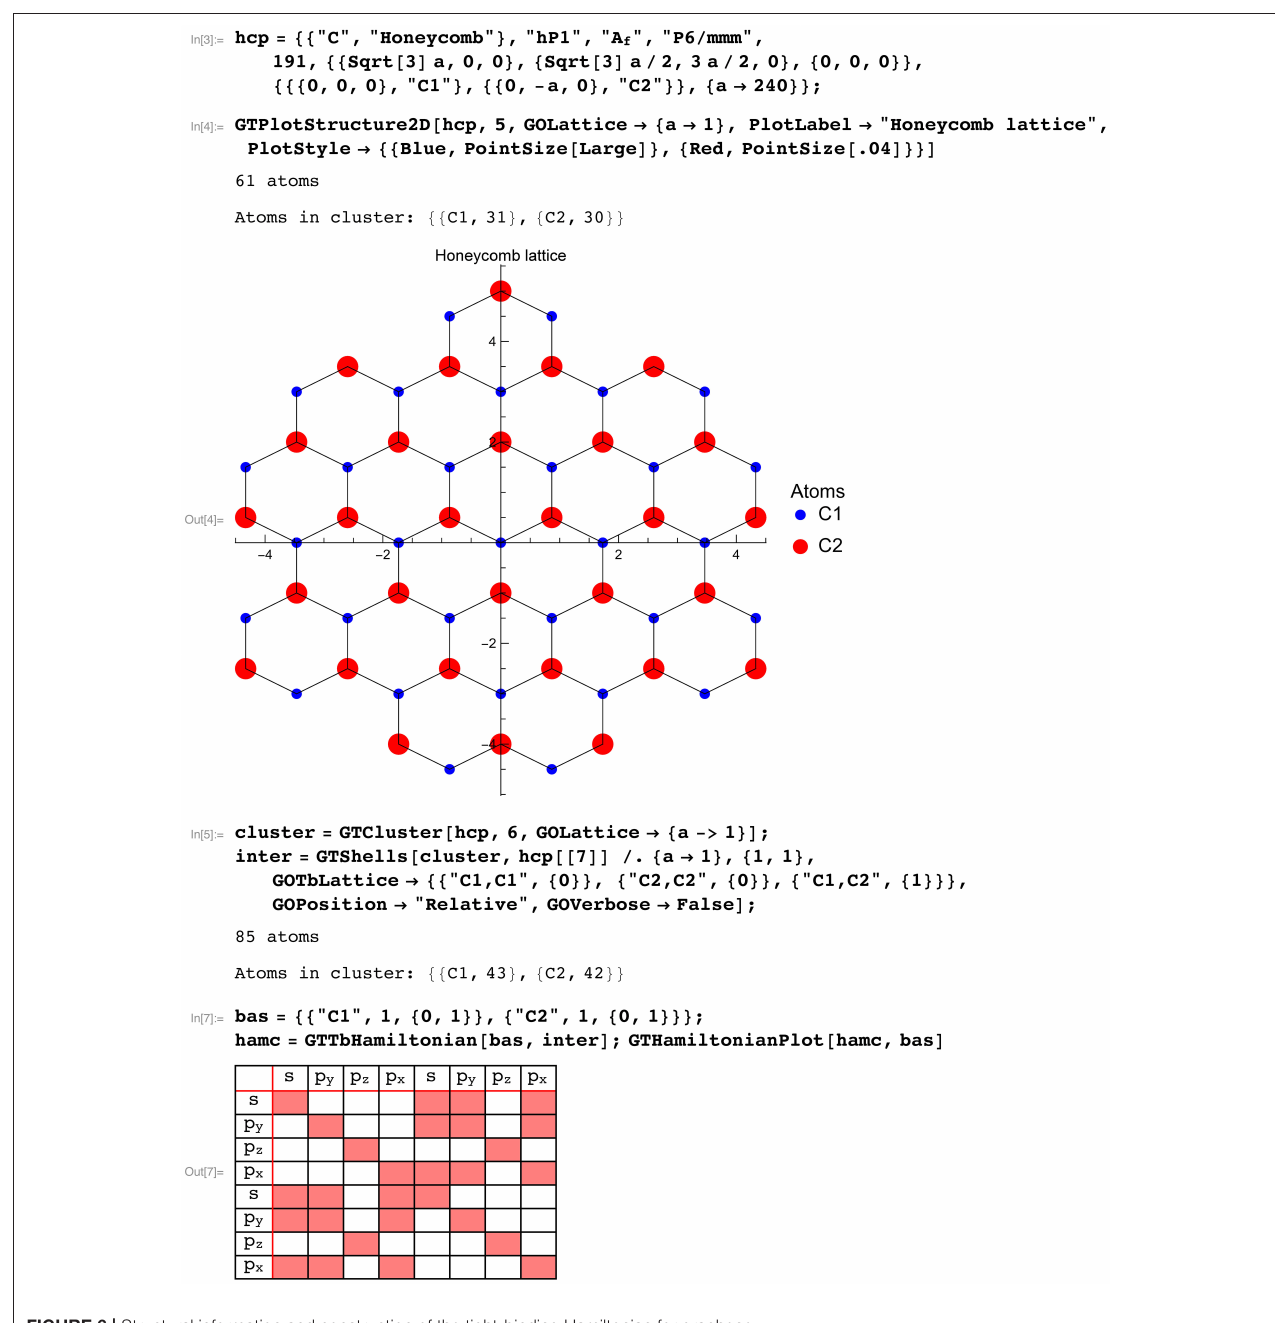
FIGURE 6 | Structural information and construction of the tight-binding Hamiltonian for